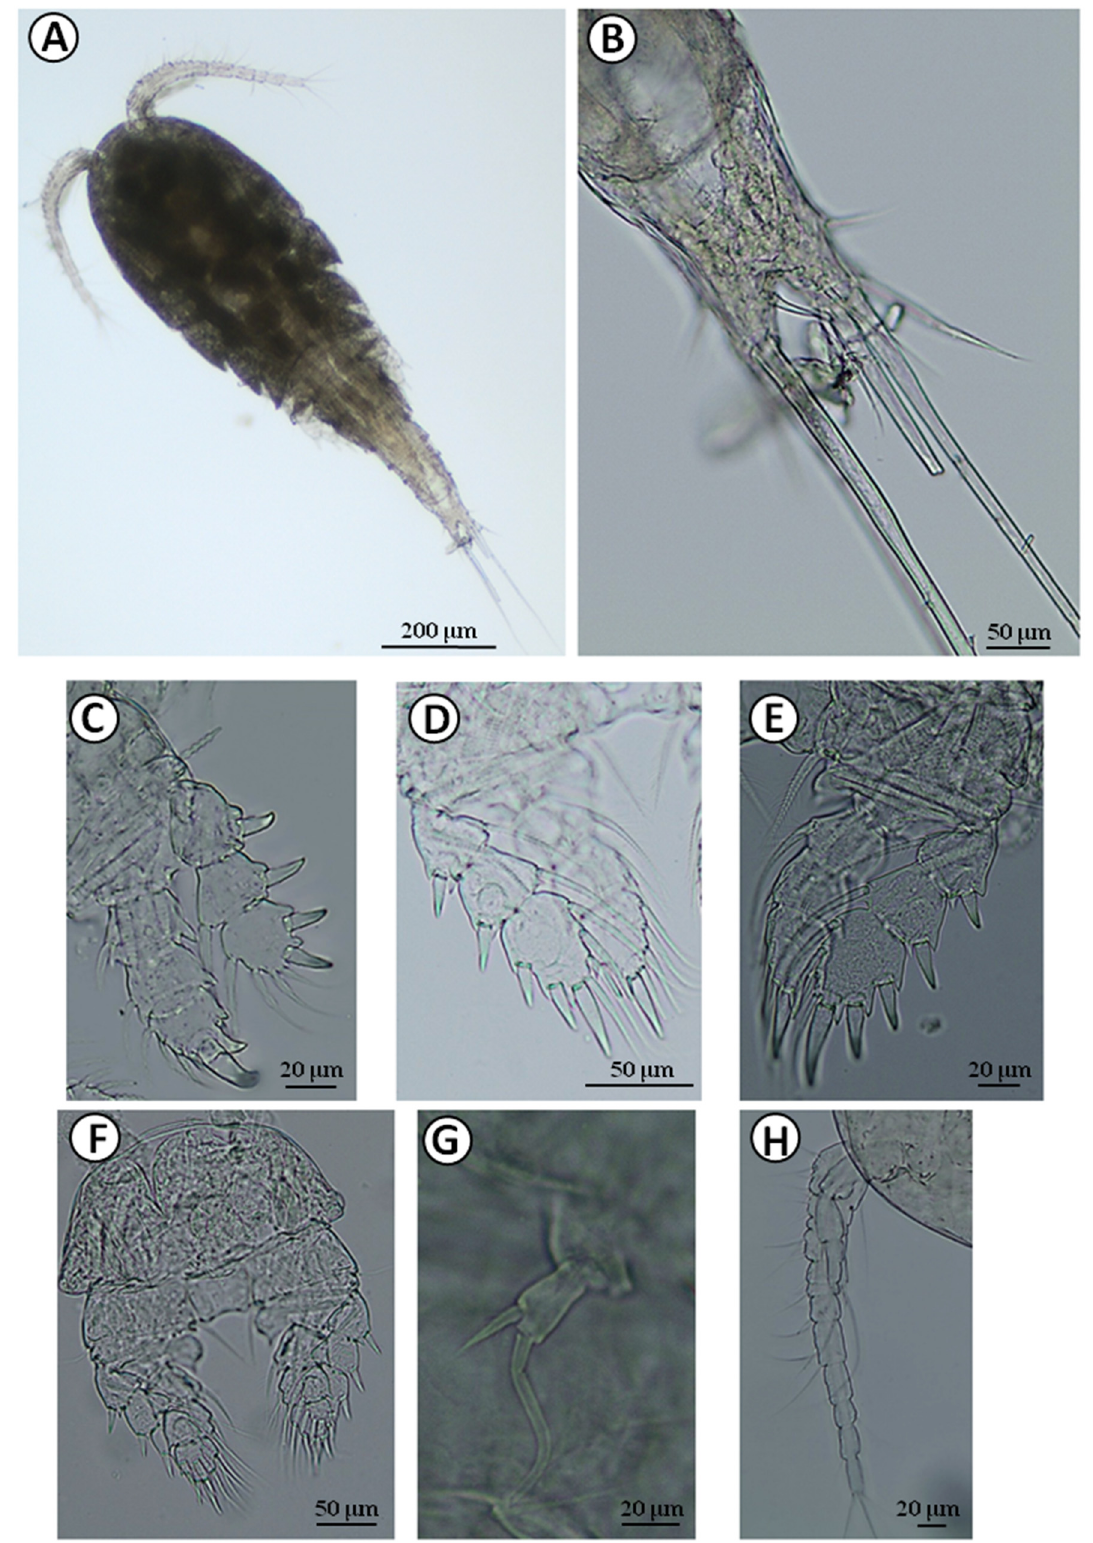
Figure 7. Diacyclops crassicaudis with aberrant development of caudal rami: A —body; B —aberrant development of furcal branches; C —P1; D —P2; E —P3; F —P4; G —P5; H —antennule. The analysis of a 525-bp mtDNA COI gene fragment amplified from studied indi- viduals from four different wells (three from Folwarki Wielkie, two from Topolany,